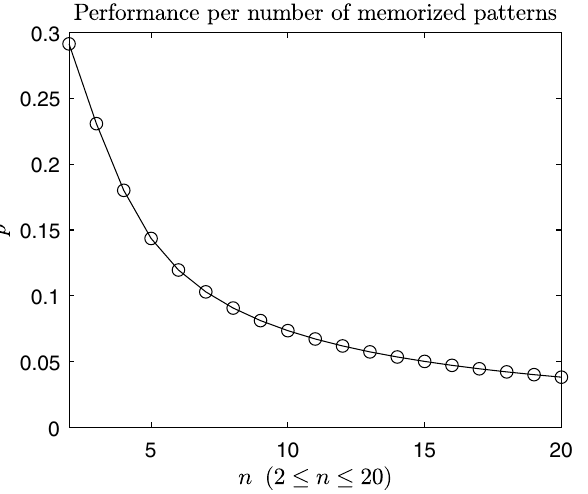
Figure 6. Memory capacity measured by the time-averaged performance: the memory representations were constructed with randomly generated 200 dimensional pattern vectors and 20 dimensional tag